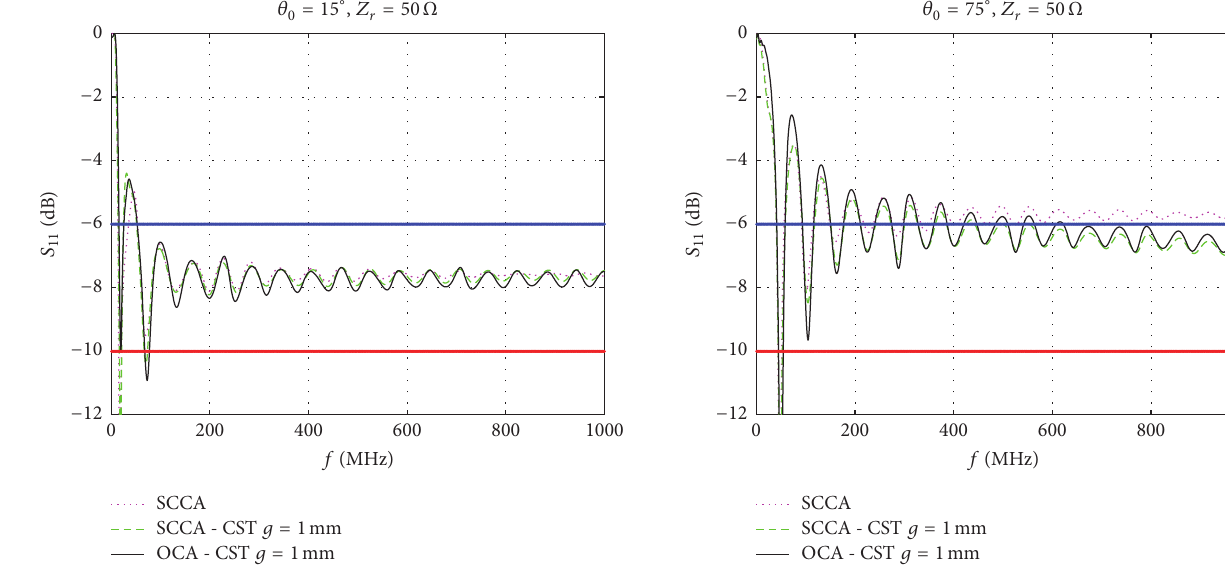
Figure 16: 𝑆 11 of thetheoretical SCCAand theCSTsimulated SCCA and OCA for 𝜃 0 = 75 ∘ and 𝑍 𝑟 = 50 Ω .